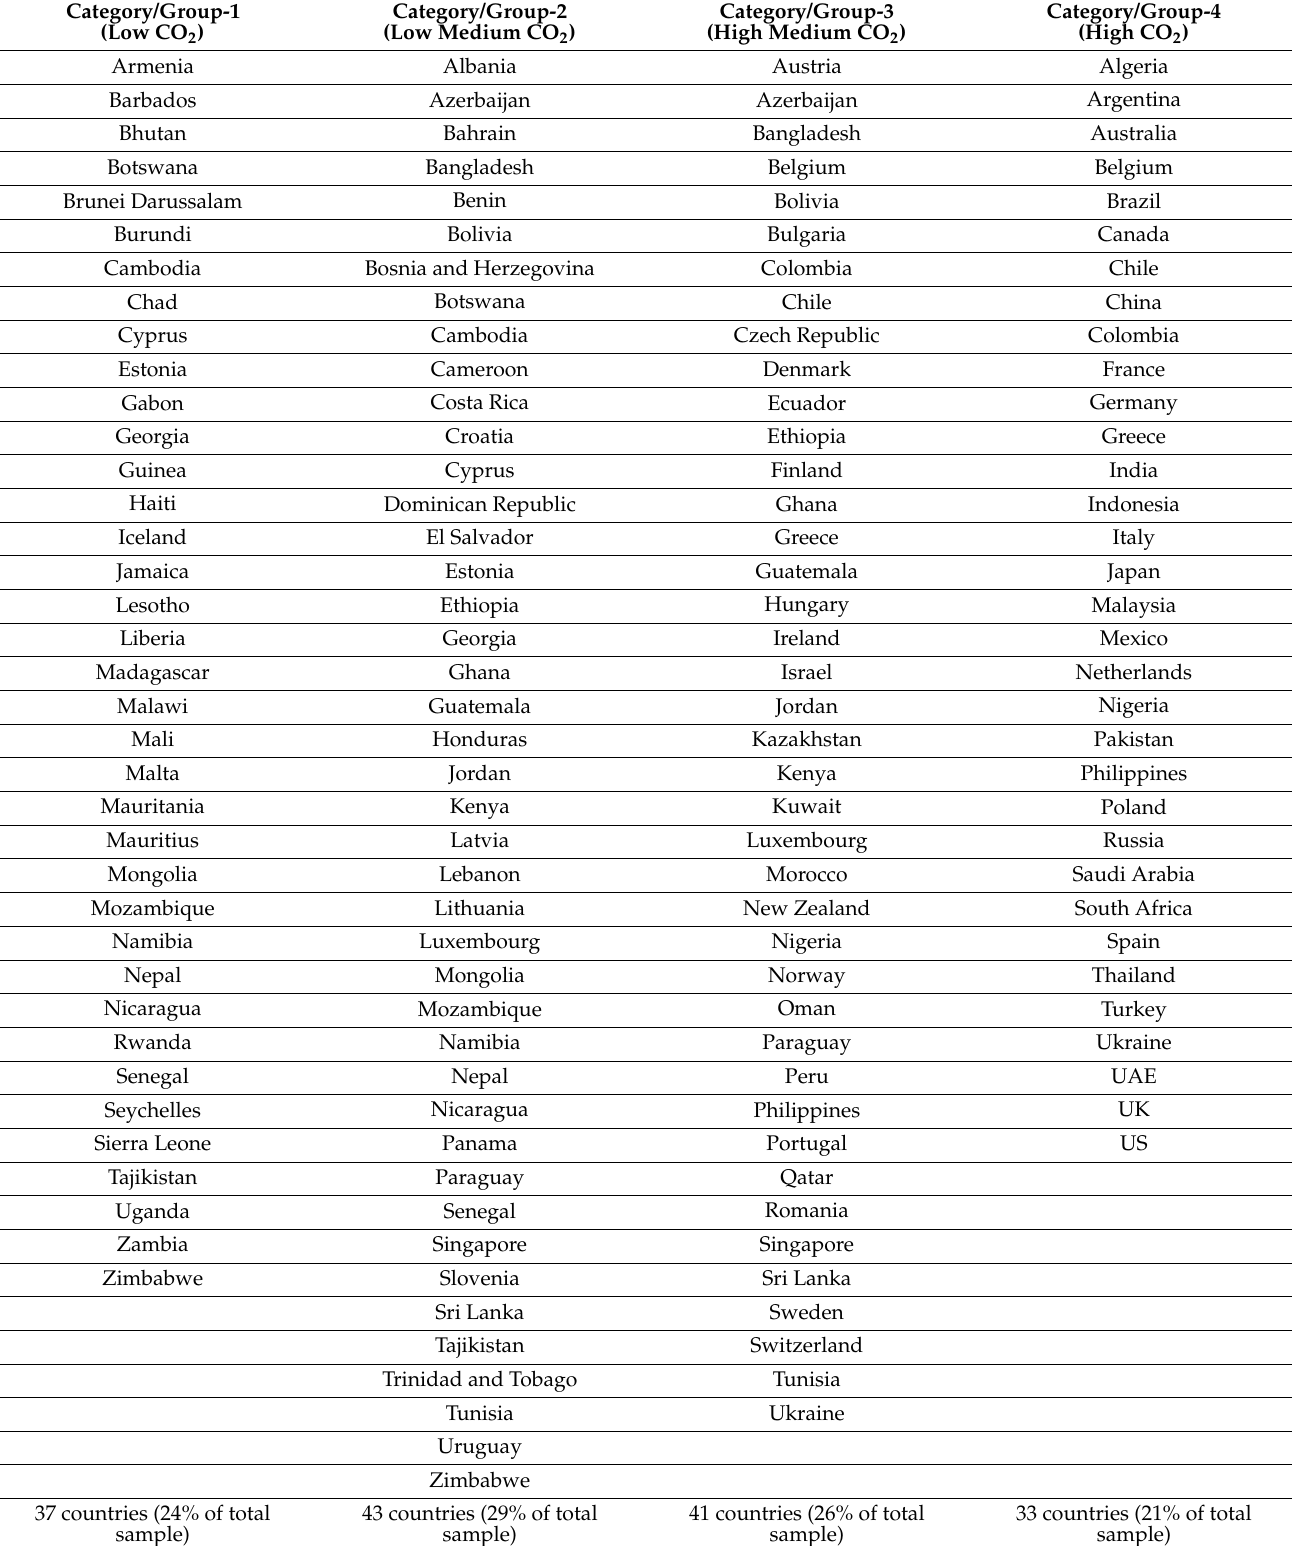
Table A1. Sample of Four Quantile Groups Based on Carbon Emissions of Transportation